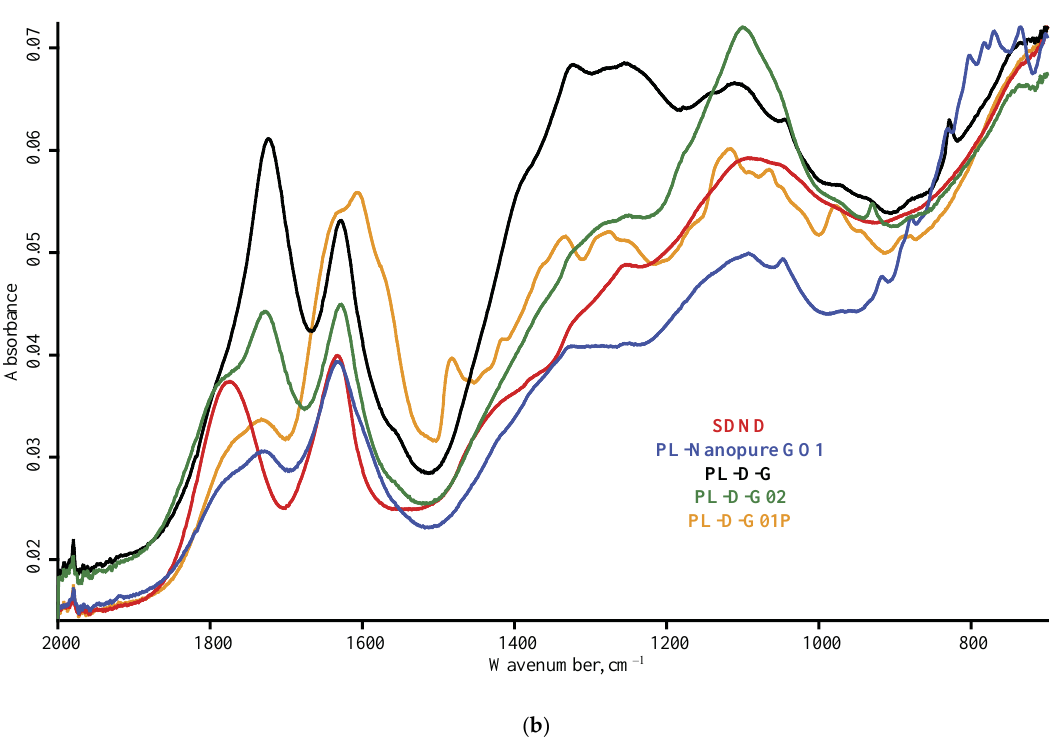
Figure 3. ATR mode, LN-MCT photovoltaic detector; nanodiamond brands: red, SDND; blue, PL-Nanopure GO1; black, PL-D-G; green, PL-D-G02; orange, PL-D-G01P; ( a ) 4000–2500 cm −1 , ( b ) 2000–400 cm −1 range. Spectra were smoothed (13 points) and normalized to maximize each spectrum.